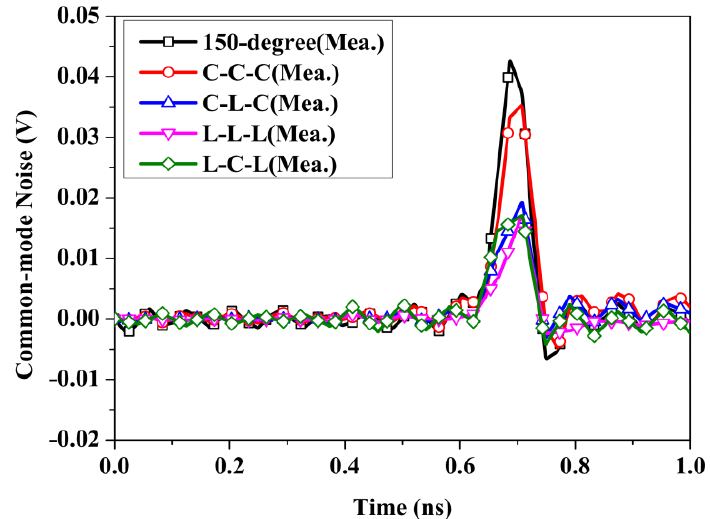
Figure 18. Measured results of common-mode noise. Table 4. The values of measured results for common-mode noise.